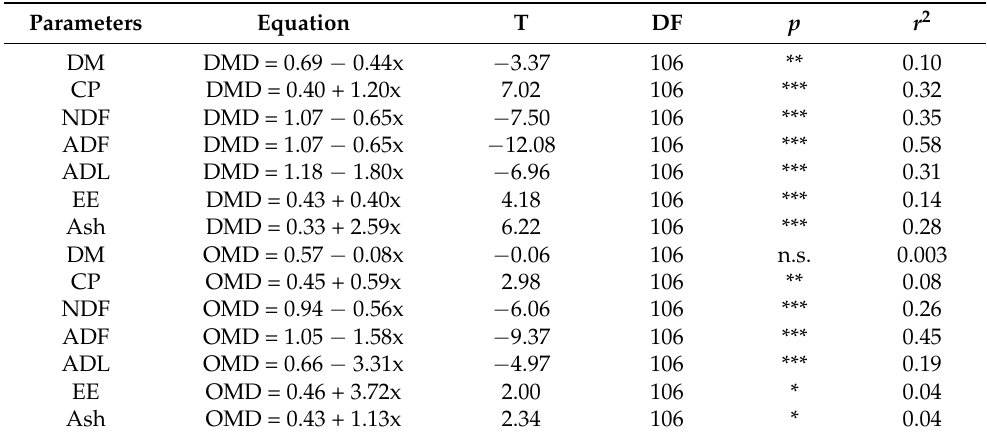
Table 2. Regression analysis between dry matter digestibility (DMD) or organic matter digestibility (OMD) and dry matter (DM), crude protein (CP), neutral detergent fibre (NDF), acid detergent fibre (ADF), acid detergent lignin (ADL), ether extract (EE) and mineral ash (Ash). n.s. = not significant; * p < 0.05; ** p < 0.01; *** p <